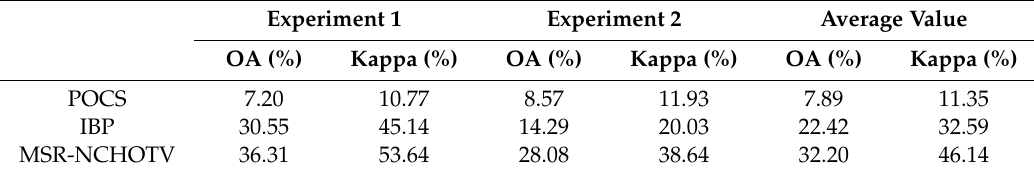
Table 11. The percentage improvements in the OA and Kappa coe ffi cient for the classifications obtained using the POCS, IBP, and MSR-NCHOTV methods, relative to the values obtained using the BI